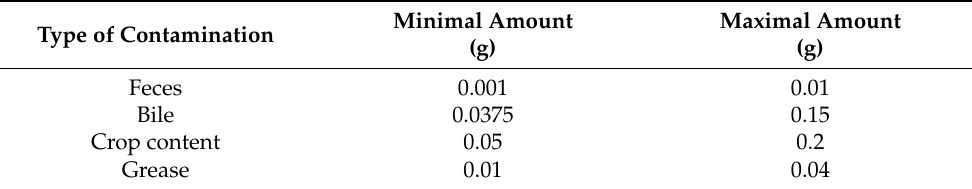
Table 1. Assumptions regarding small contaminations on broiler carcasses as input for the Monte Carlo